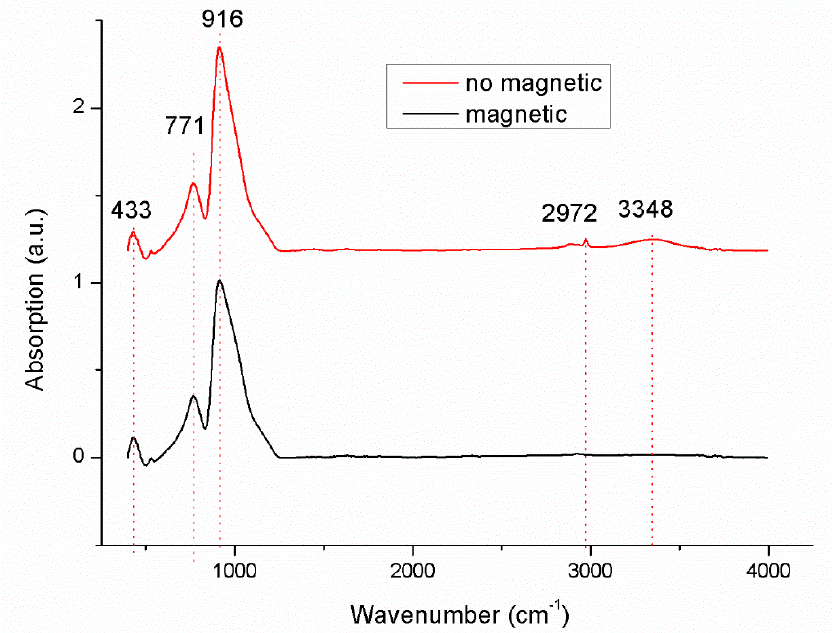
Figure 2. FTIR spectra of sparked discharged wires inside and outside of magnetic field.